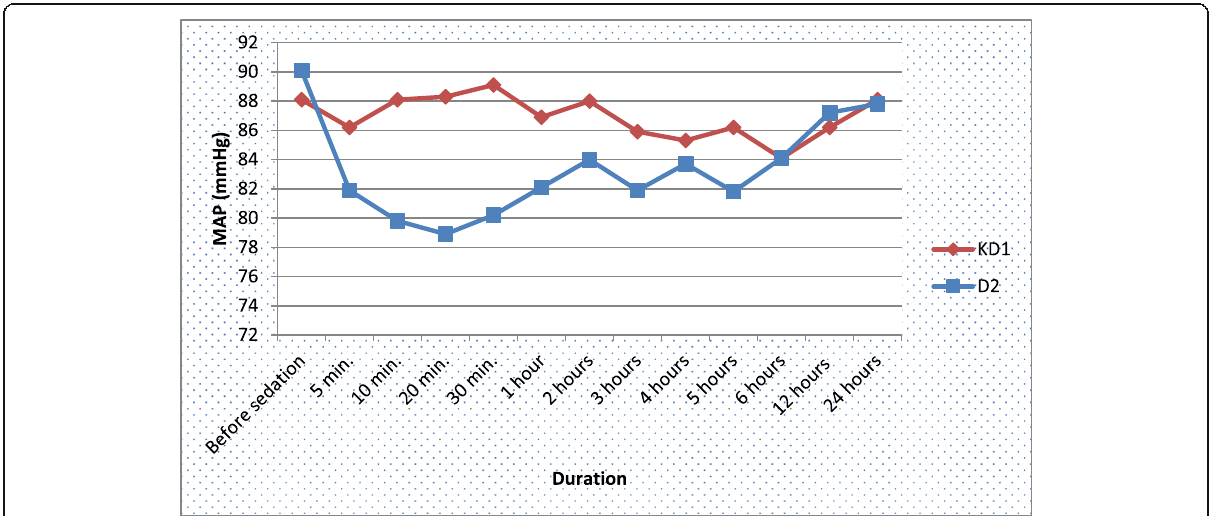
Fig. 3 Mean arterial pressure (MAP) changes in the studied two groups. KD 1 , ketamine-dexmedetomidine group. D 2 , dexmedetomidine group. MAP, mean arterial pressure. Statistically significant drop of MAP in group D 2 compared with group KD 1 ( P value < 0.001)